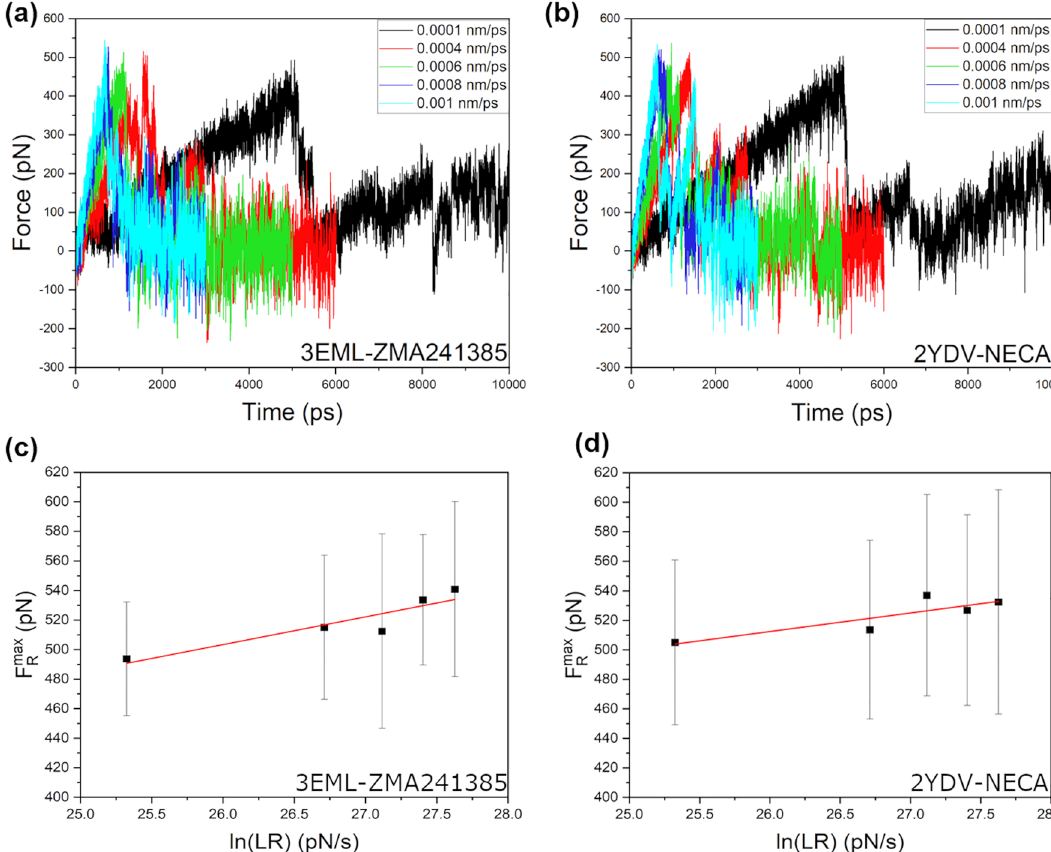
Figure 4. Representative unbinding force profiles of one randomly selected replica out of 41 replica SMD simulations at each of the pulling velocities for ( a ) ZMA241385 and ( b ) NECA ligand-receptor complexes. Linear least-square regression of the average maximum unbinding forces ( F R max ) versus natural logarithms of the LR calculated from the SMD simulations of ( c ) ZMA241385 and ( d ) NECA ligand-receptor systems. Standard deviations for the average F R max values are shown as black error